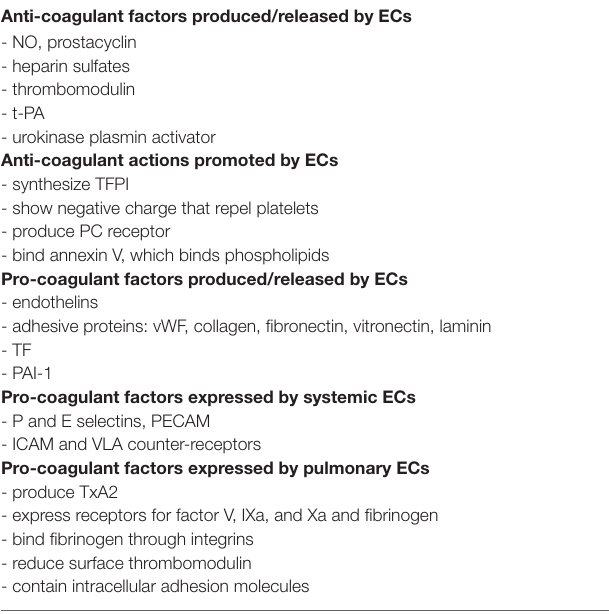
TABLE 2 | Endothelial cell properties. Anti-coagulant factors produced/released by